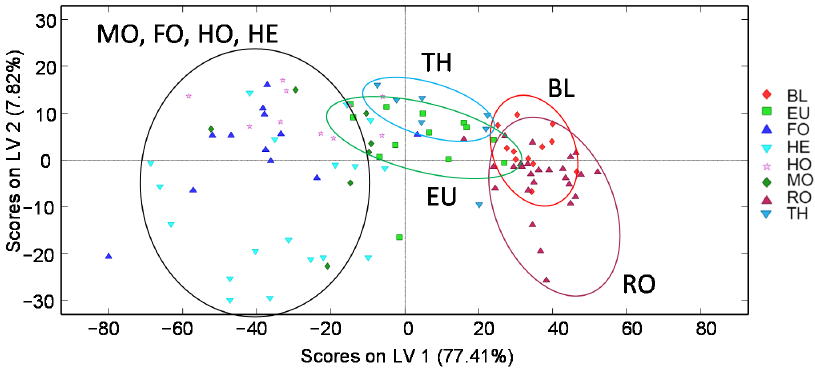
Figure 6. PLS-DA score plot of LV1 vs. LV2 when using off-line SPE HPLC-UV polyphenolic fingerprints (at 280 nm) as honey chemical descriptors for botanical origin classification (4 LVs were used to build the model). QCs and multifloral honeys were excluded. BL: Orange/lemon blossom; EU: Eucalyptus; FO: Forest; HE: Heather; HO: Holm oak; MO: Mountain; RO: Rosemary; TH: Thyme.